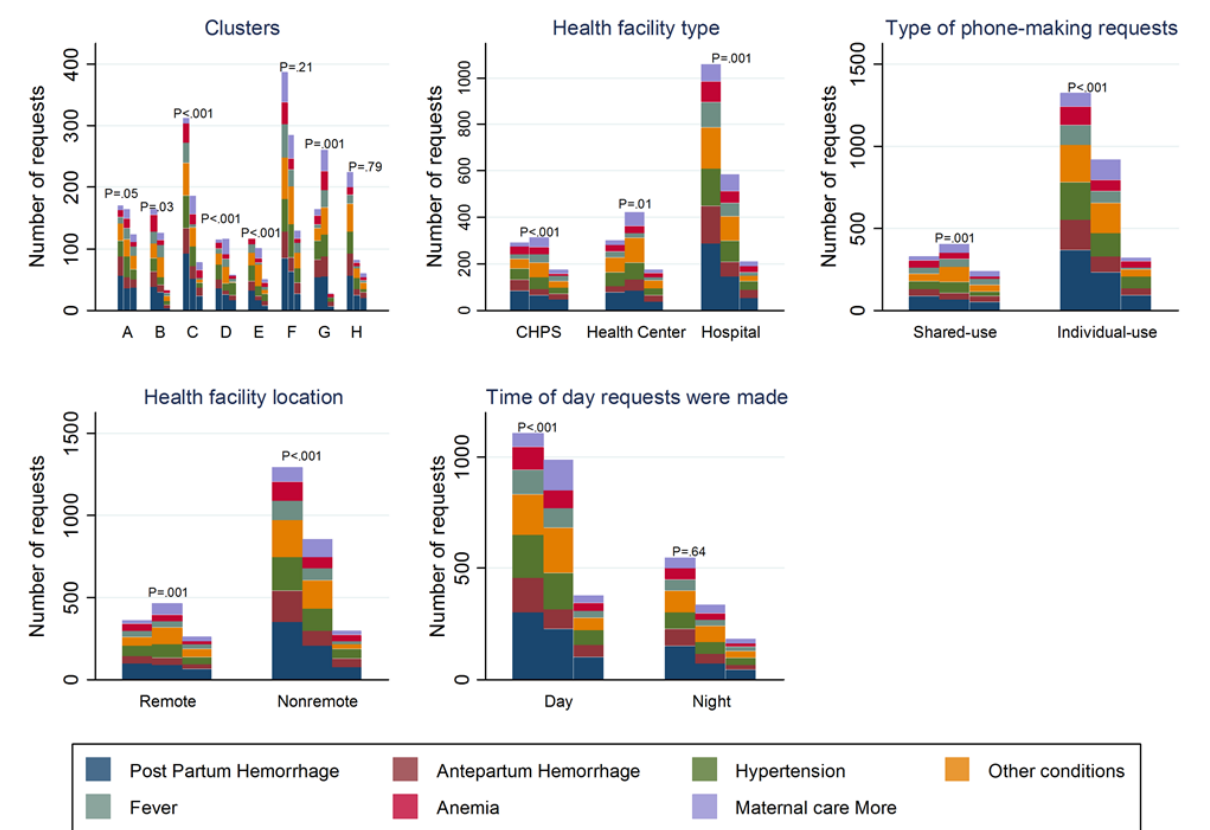
Figure 1. Maternal requests at 6-month interval by cluster, health facility type and location, phone type, and time of day requests were made. P values are chi-square tests or Fisher exact test comparing requests within each subcategory of each explanatory variable at 6-month intervals. Clusters have been labeled A-H for anonymity; CHPS: Community-based Health Planning and